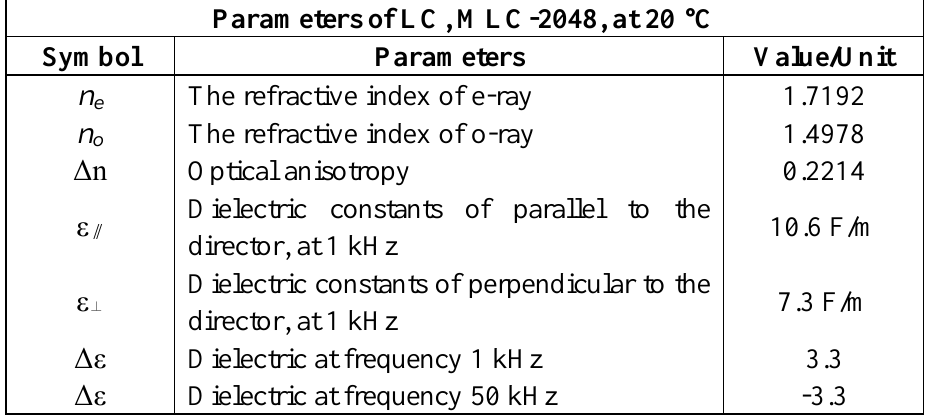
Table 2. The parameters for DFLC, MLC-2048.